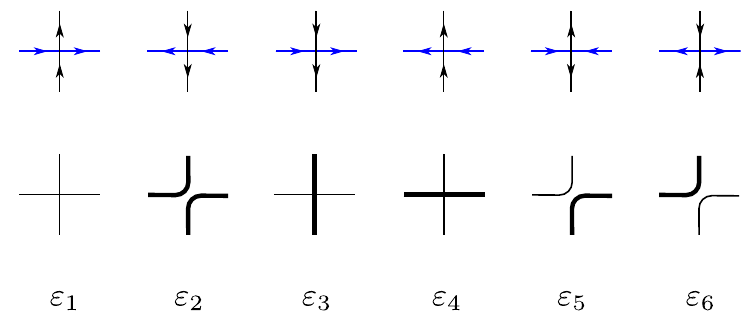
Figure 1 . Con(cid:12)gurations of 6-vertex